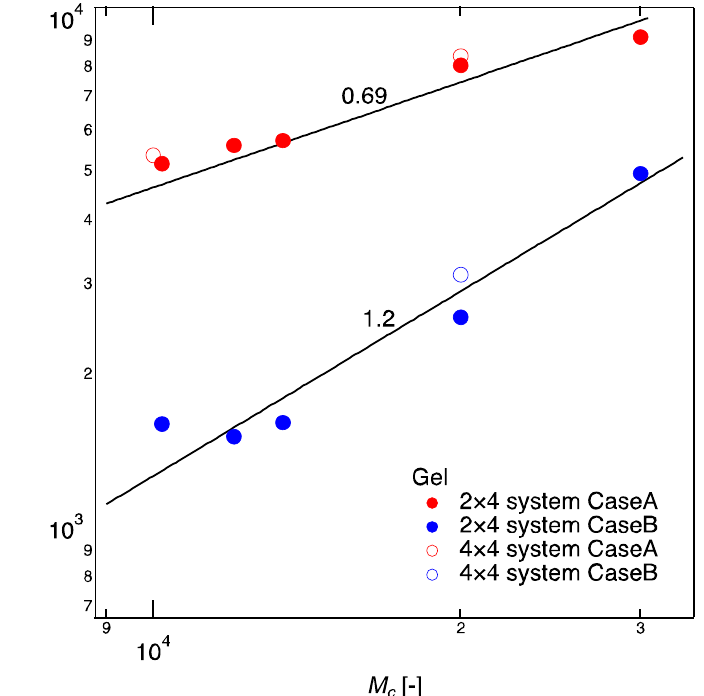
Figure 4. Shear modulus ( G (cid:48) ) of 2 × 4 gels as a function of molecular weight between crosslinkers ( M c ). Data of Case A are shown in red and those of Case B are shown in blue. 4 × 4 gels with corresponding tetra-PEG concentration are shown as controls. The solid lines denote the fitting curves of G (cid:48) ∼ M c 0.69 and G (cid:48) ∼ M c 1.2 for Cases A and B, respectively. The values of G (cid:48) of 4 × 4 gels are cited from the study of Akagi et al. (tetra-PEG 20 k ( M c 10 k), φ = 0.051 (= 3.0 mM ) and tetra-PEG 40 k ( M c = 20 k), φ = 0.096 (= 3.0 mM ) as controls for Case A; tetra-PEG 40 k ( M c = 20 k), φ = 0.051 (= 1.5 mM ) as a control for Case B) [17].